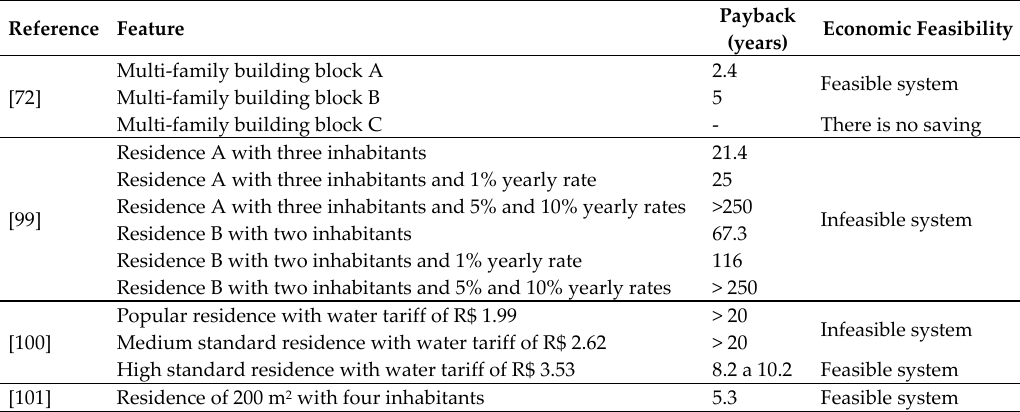
Table 2. Paybacks for the implantation of rainwater harvesting systems in residential